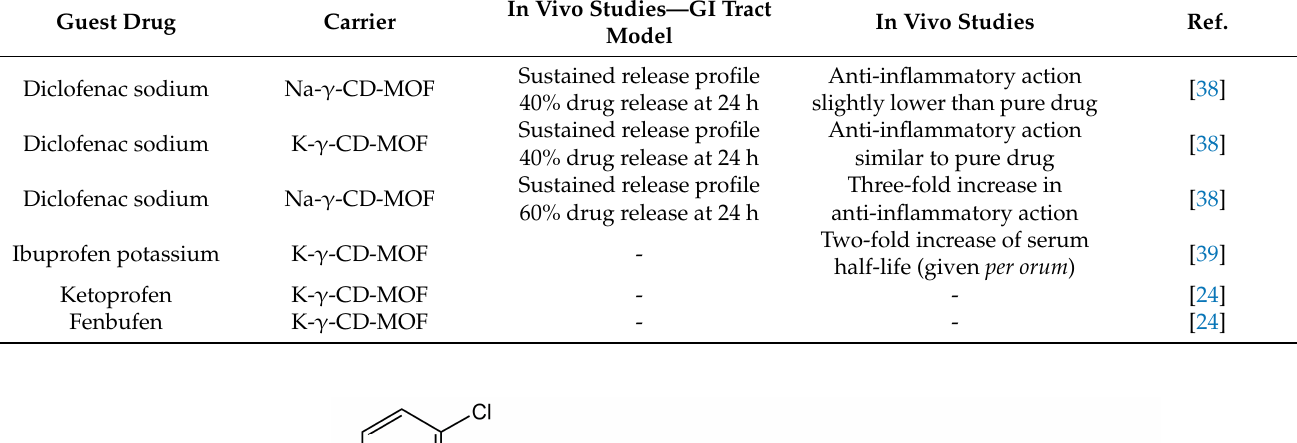
Table 1. Overview of literature pharmacologic data on NSAID-loaded γ -CD-MOF systems.